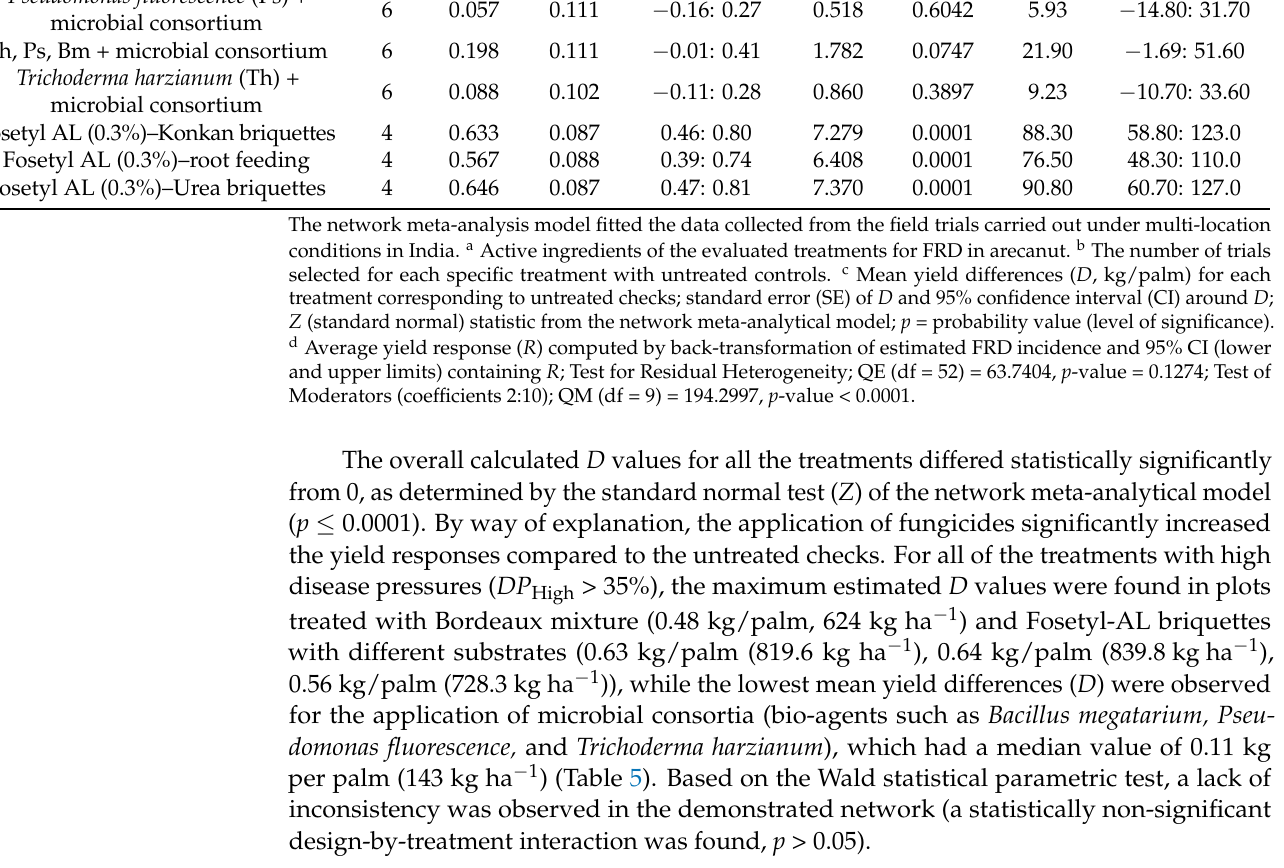
Table 5. Average arecanut yield differences ( D ) among treated plots and untreated controls (low yield level) estimated through the network meta-analysis with related model parameters and computed yield response (%) for the evaluated treatments for FRD ( DP High > 35%).